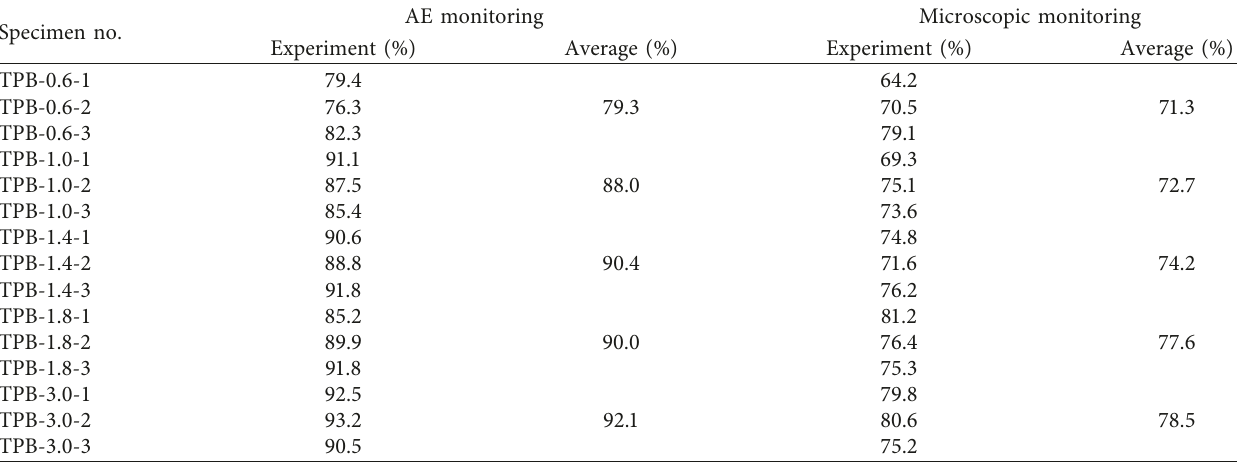
Figure 8: Typical microscopic failure modes at the peak for five loading rates, as observed using the microscopic visualization monitoring system. Table 2: Crack initiation loads of specimens with different loading rates obtained from AE results and microscopic visualization monitoring